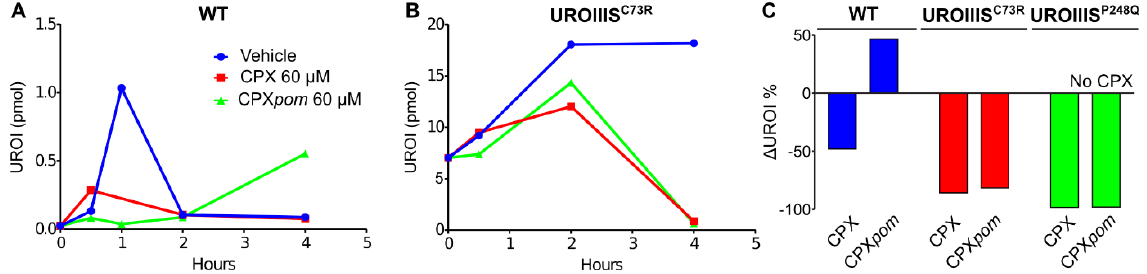
Figure 5. Effect of CPX and derivatives in the UROI concentration as a function of time in cellular models of CEP. ( A ) WT HEK cells, ( B ) HEK cells modified by CRISPR/Cas9 to introduce the mutation C73R in the UROIIIS gene, and ( C ) normalized comparative analysis of the URO I concentration in the presence or absence of CPX and CPX pom and for two different cellular models of CEP (C73R and P248Q).